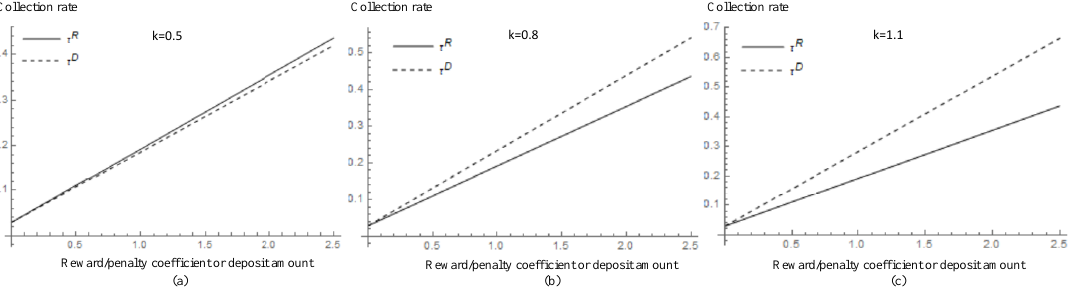
Figure 4. The impact of reward/penalty coefficient or deposit amount on collection rate (The variation of collection rate at k = 0.5 ( a ), the variation of collection rate at k = 0.8 ( b ) and the variation of collection rate at k = 1.1 ( c )).